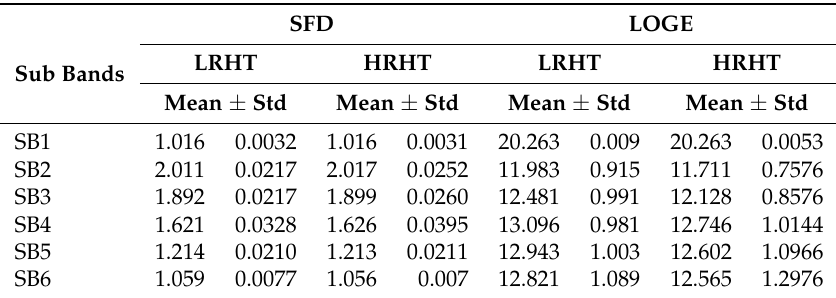
Table 3. Mean and standard deviation for